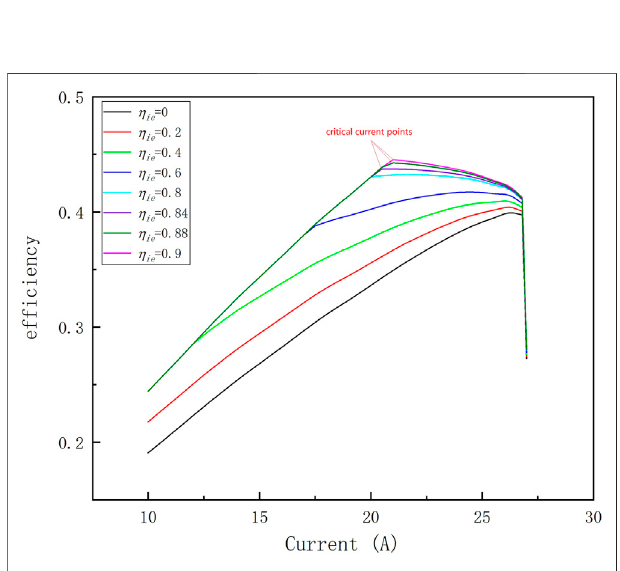
FIGURE 8 | Output characteristics of the system under different η ie .